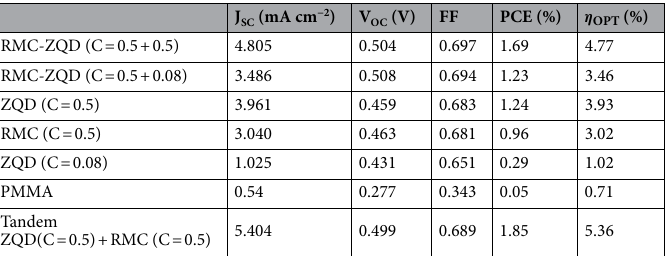
Table 1. Photovoltaic parameters obtained from PCE measurements. The short-circuit current density ( J SC ) was estimated based on LSC front surface areas of 2.5 cm × 2.5 cm, and 4 PV cells were attached in